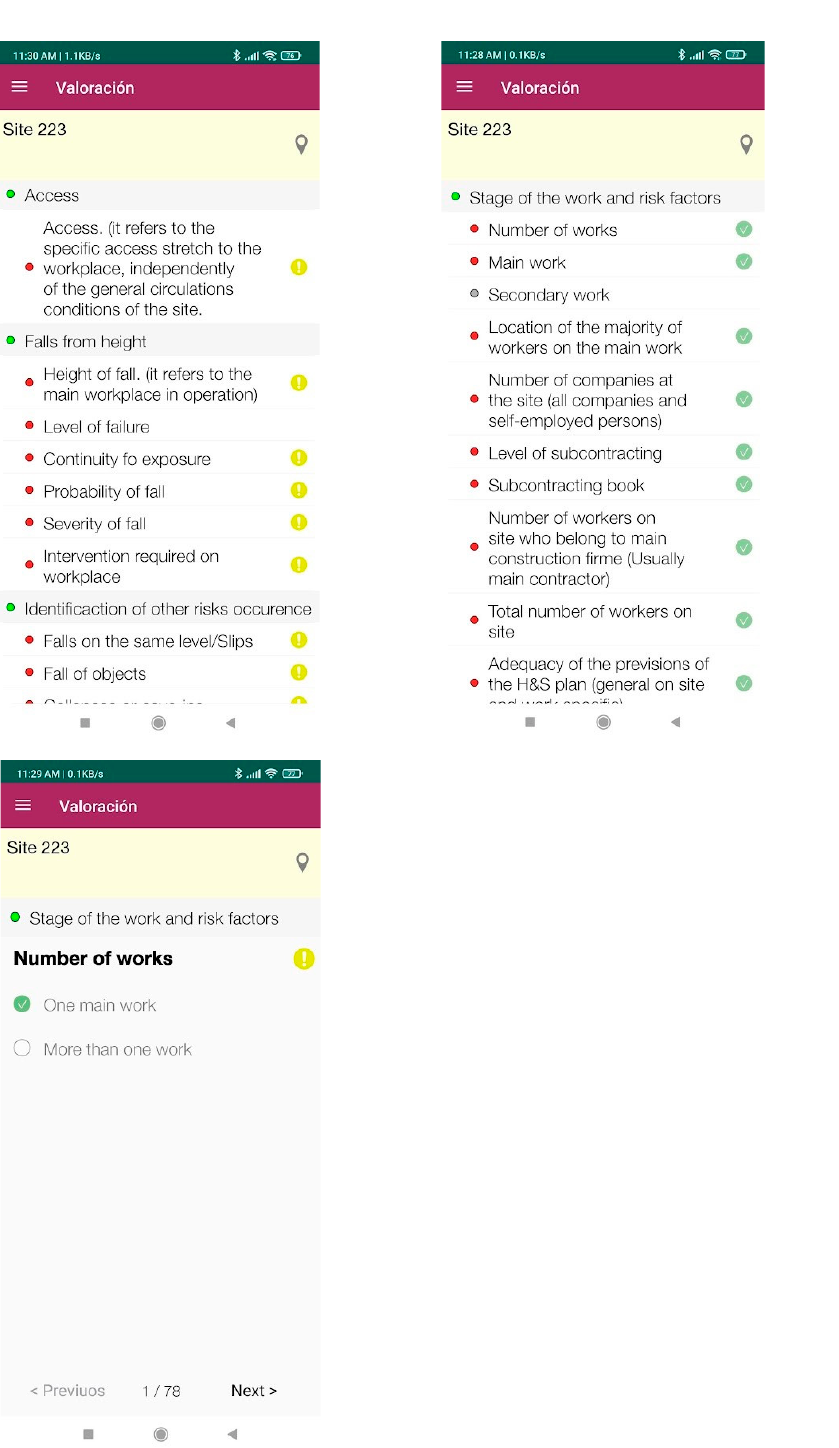
Figure A2. Questions for site characterization. Finalization of characterization and continuing as- sessment. Source: App screenshots.